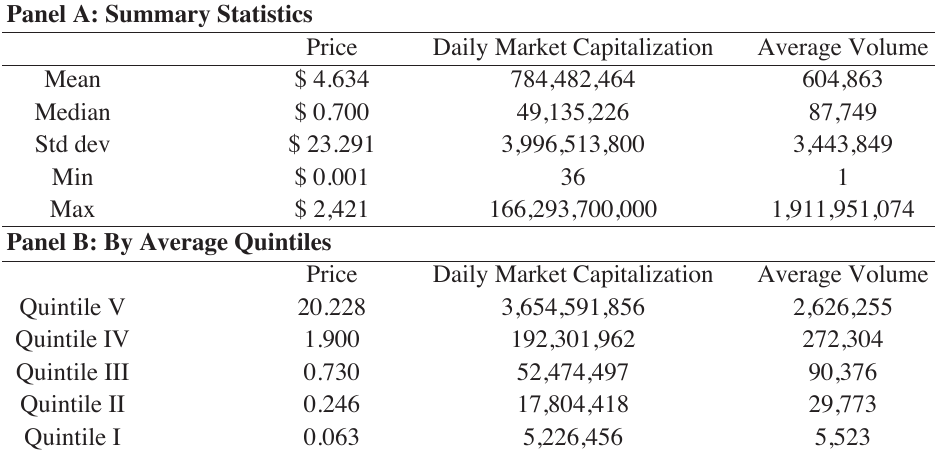
Table 1. Descriptive Statistics of Stocks Panel A: Summary